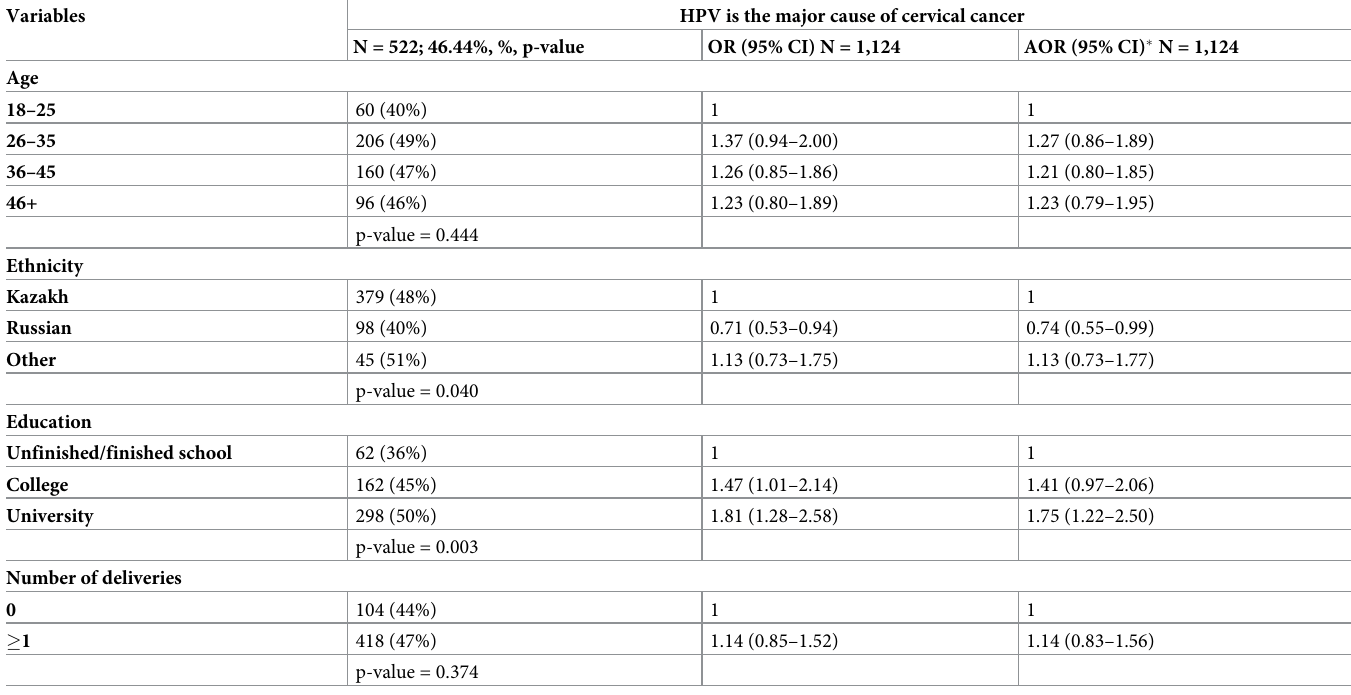
Table 3. Knowledge of HPV as the major cause of cervical cancer among women visiting gynecological clinics, (N = 1,124). Variables HPV is the major cause of cervical cancer N = 522; 46.44%, %,